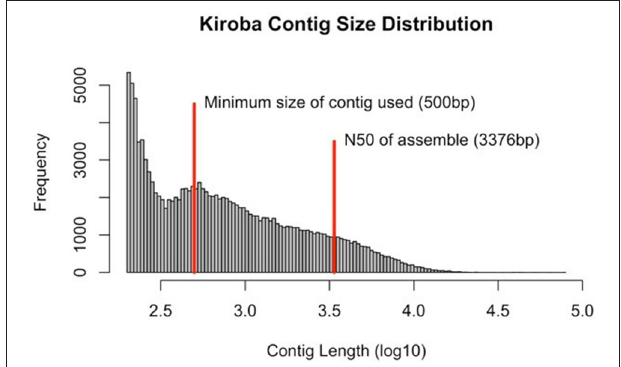
FIGURE 4 | Kiroba genome assembly showing the contig size in log 10. The minimum size used in the scaffold assembly was 500 bp (blue line) and the N50 (3,376 bp) of the contigs assembly (red).